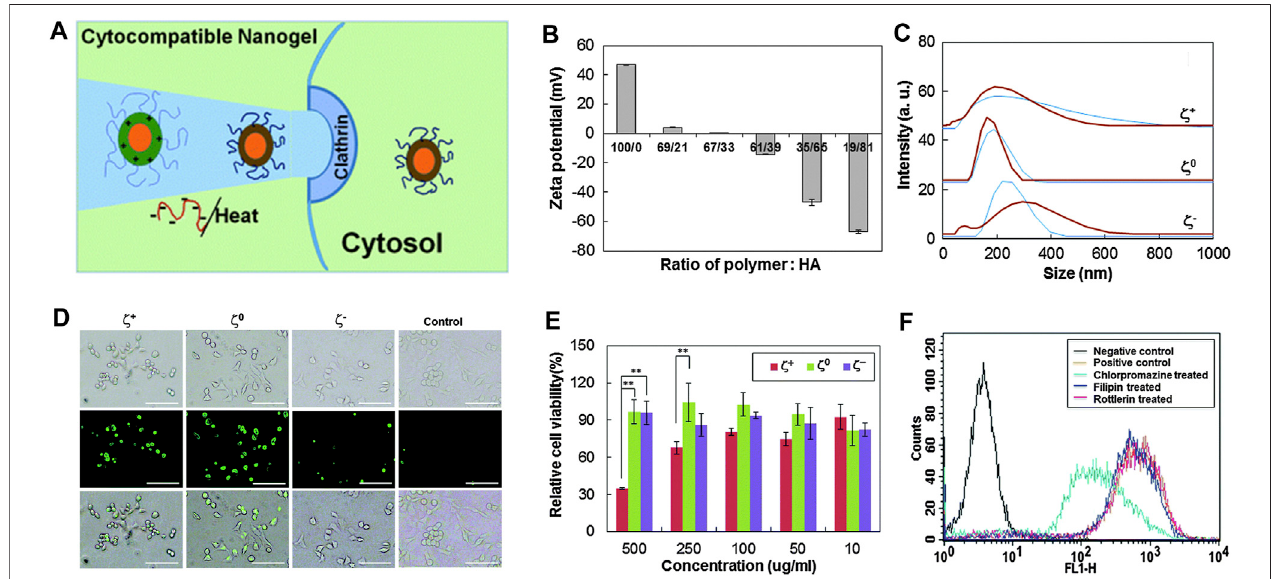
FIGURE 10 | Physical and cellular characterization of temperature-sensitive nanocarriers (Ko et al., 2015). (A) Schematic diagram of temperature-sensitive nanocarriers. (B) ζ potentialofnanogelspreparedbyPEG-PK-PAandHA). (C) Relationship betweentheparticlesizedistributionofnanogelsanddifferenttemperatures (blue curve for 20 ° Cand brown curve for 37 ° C). (D) Endocytosis after incubation for 12 h. (E) Relationship between the cytotoxicity of PEG-PK-PA/HA and the concentration of nanogels. (F) After inhibitor treatment, fl uorescence-activated cell sorting data were compared to analyze the internalization of fl uorescein